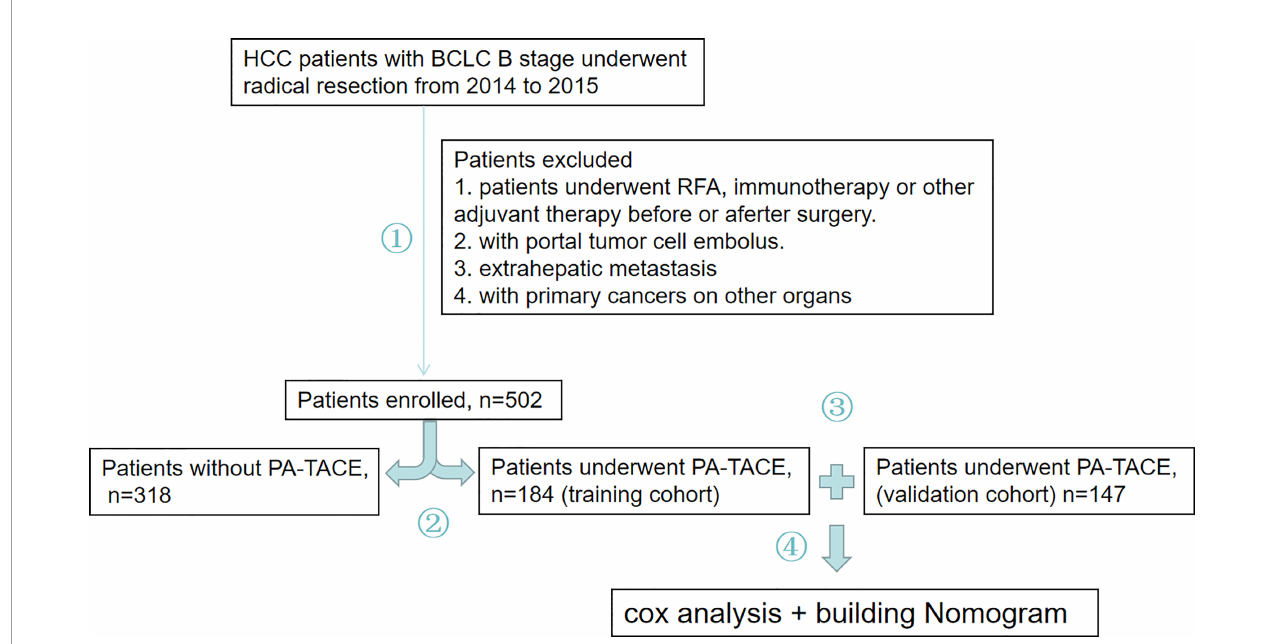
FIGURE 1 | Study overview. 1. Stage B HCC patients who received radical resection from 2014 to 2015 were evaluated. A total of 502 patients were enrolled in our study, and patients were removed based on struct inclusion criteria needed for further analysis. 2. These patients were divided into a PA-TACE group or a group without PA-TACE group. 3. Finally, 184 patients who received PA-TACE were included in the training cohort, and an additional 147 patients who received PA-TACE following the same screening criterion as the training cohort were included in a validation cohort. 4. A novel nomogram was produced to predict RFS in HCC patients who received PA-TACE after radical